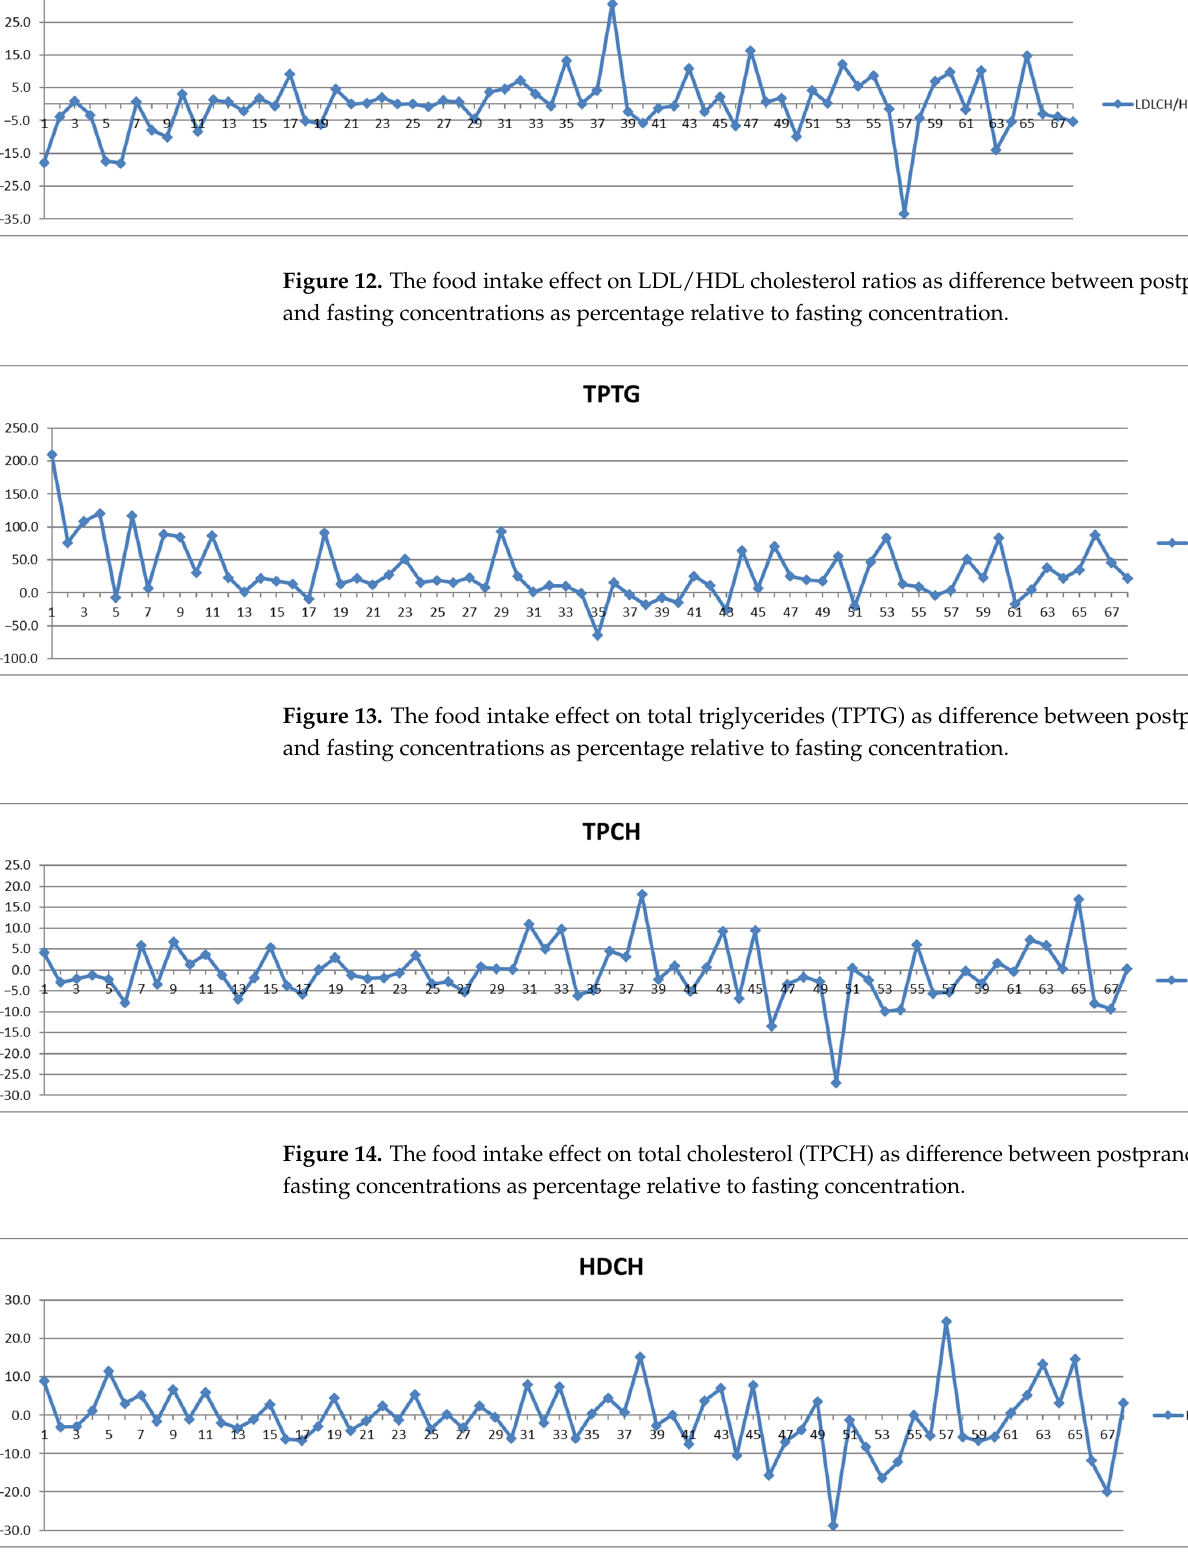
Figure 15. The food intake effect on HDL cholesterol (HDCH) as difference between postprandial and fasting concentrations as percentage relative to fasting concentration.